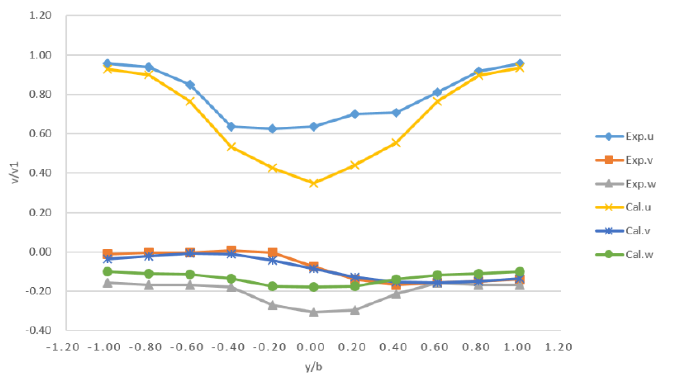
Figure 7. Location of observation points. Figure 8. Comparison of experimental and calculated three velocity components at observation points.